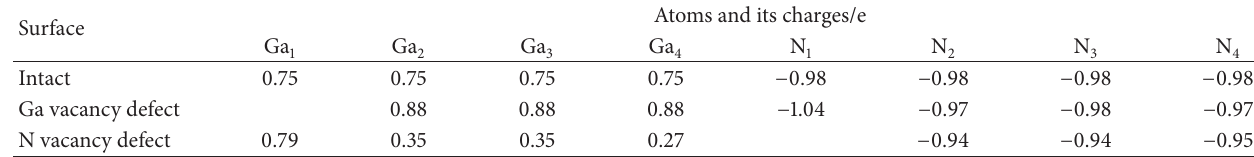
Table 1: Charges of atoms in the outmost layer of intact, Ga vacancy defect, and N vacancy defect surfaces. Surface